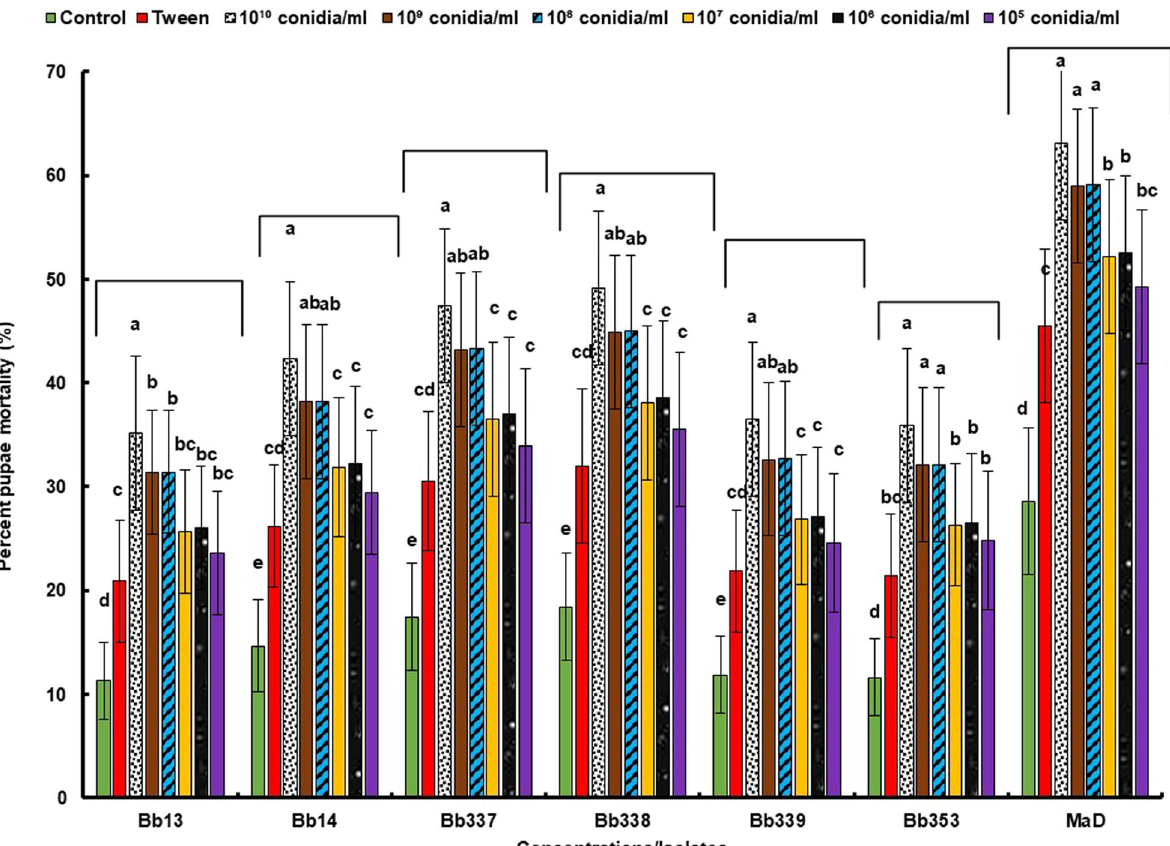
Fig. 2 Mortality of pupae of Zeugodacus cucurbitae treated with different concentrations of isolates of Beauveria bassiana and Metarhizium anisopliae in larval inoculation